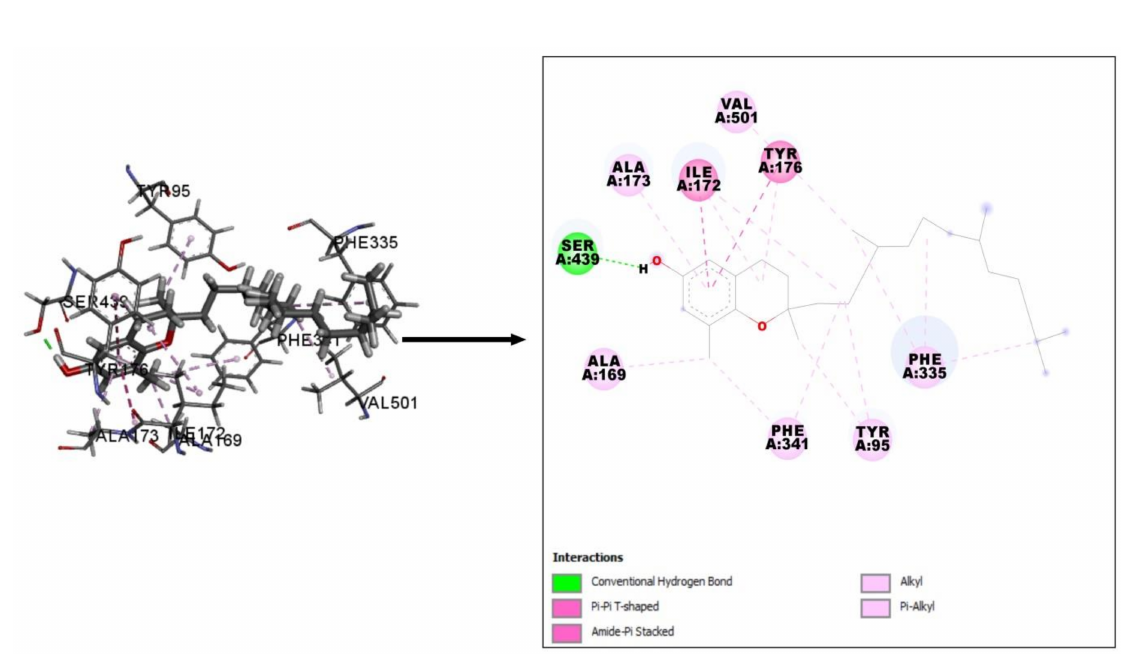
Figure 7. Best-docked interaction between 2H-1-benzopyran-6-ol, 3,4-dihydro-2,8-dimethyl-2-(4,8,12-trimethyltridecyl)-, [2R-[2R*(4R*,8R*)]]- and human serotonin receptor (PDB ID: